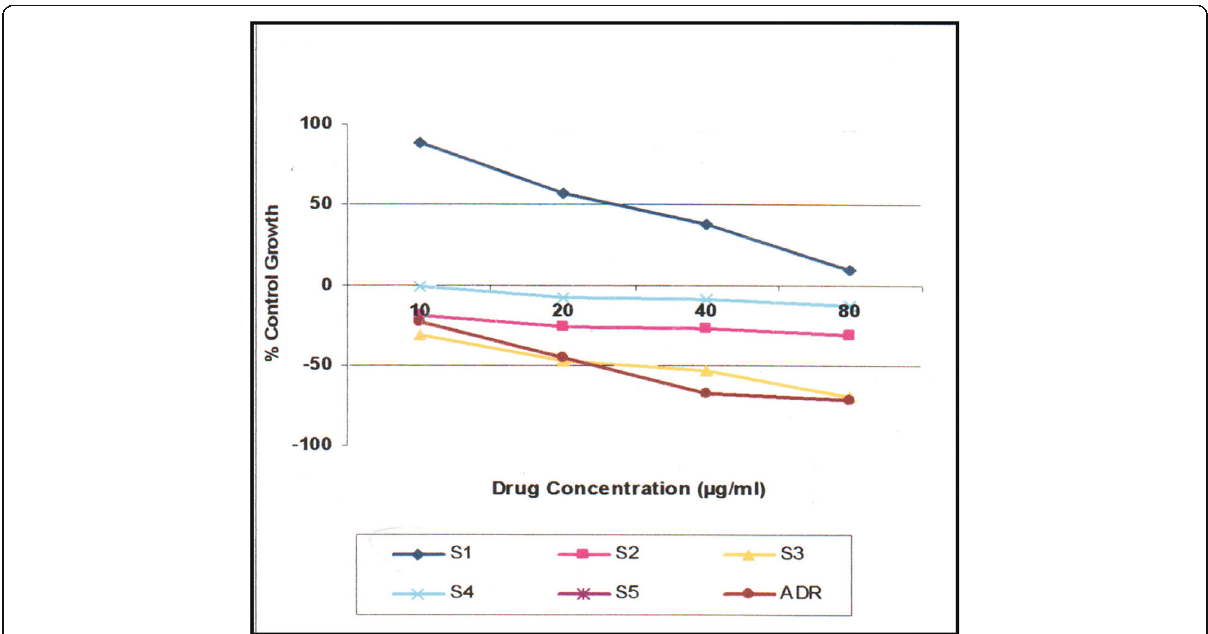
Fig. 4 Growth curve: human breast cancer cell line BT 474 compounds 1 -